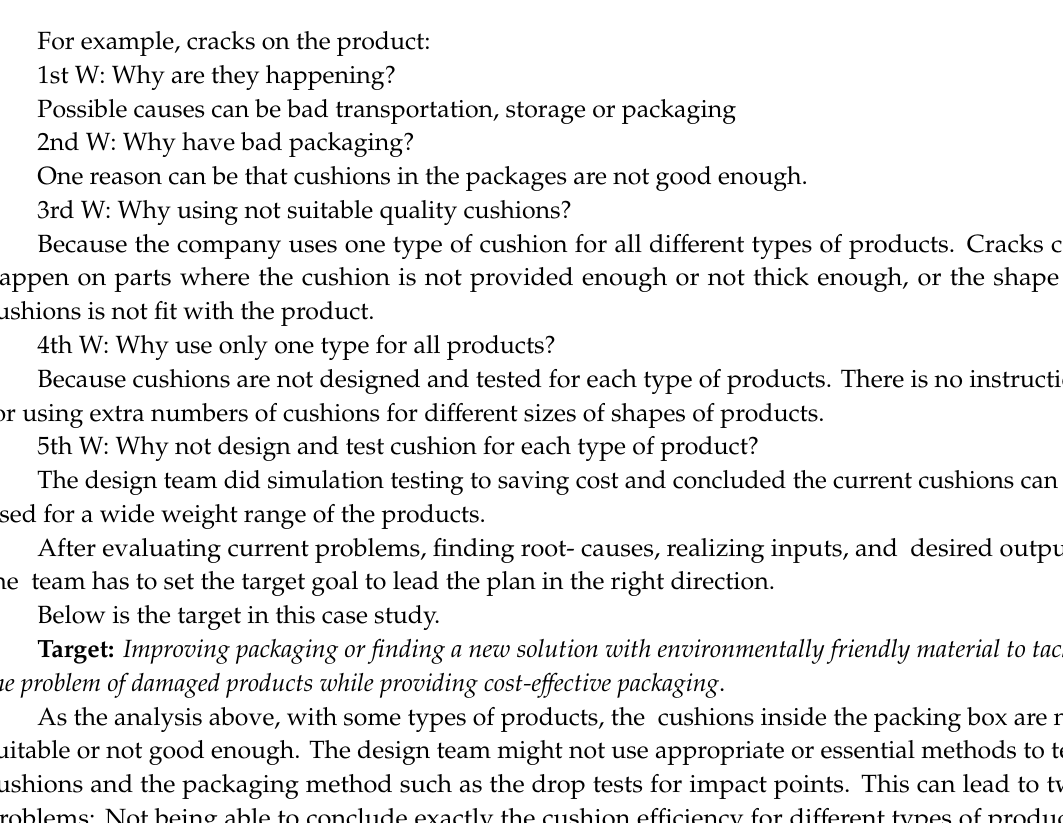
Figure 2. Ishikawa diagram for possible causes creating crack.